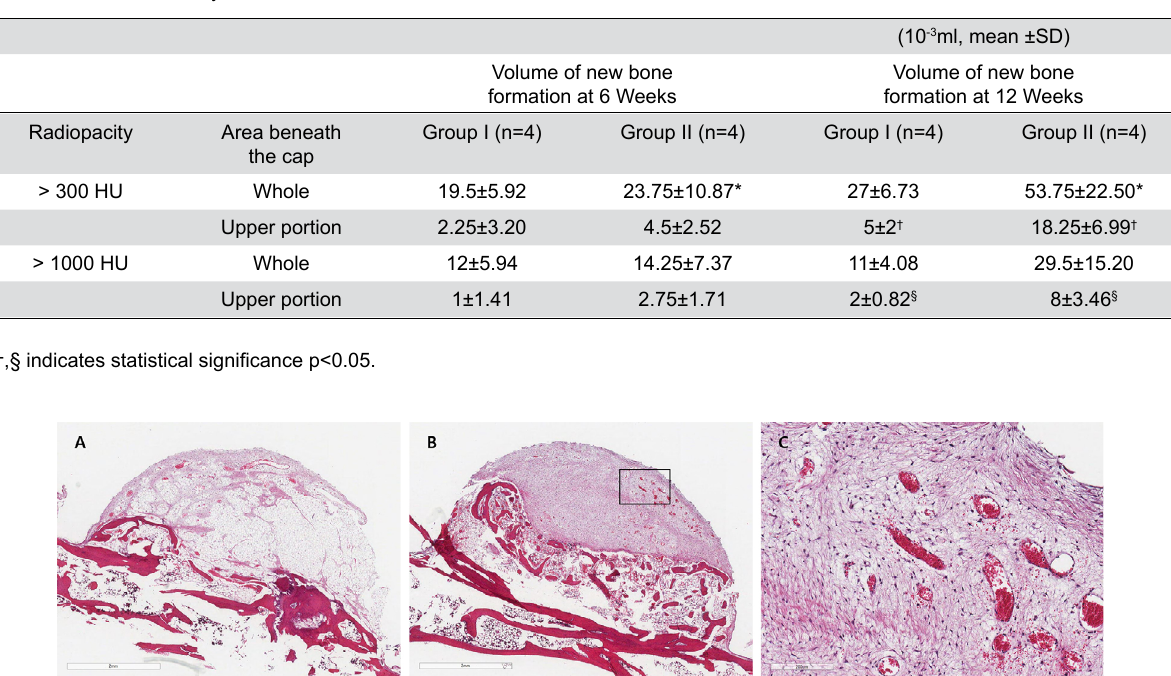
Table 1- Quantitative analysis of the volume of new bone formation